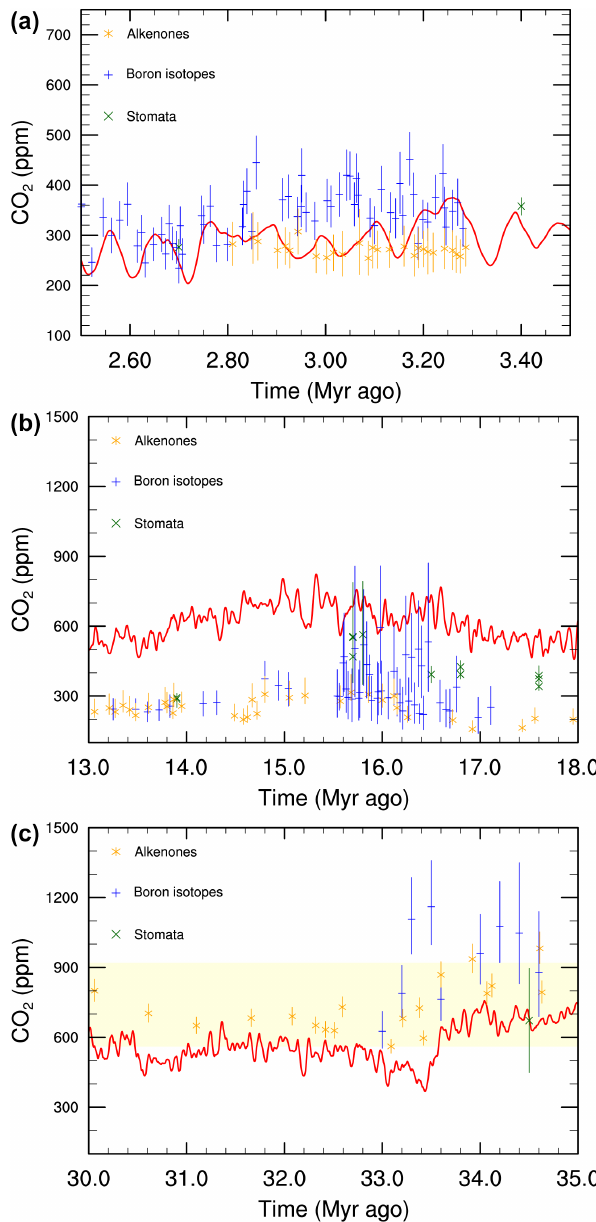
Figure 5. Simulated CO 2 concentrations of the new reference run (red line) for the (a) Late Pliocene (3.5 to 2.5Myr ago), (b) Middle Miocene (18 to 13Myr ago), and (b) Early Oligocene (35 to 30Myr ago); 40kyr running averages are shown. Proxy data reconstructions based on alkenones (Pagani et al., 1999, 2011; Badger et al., 2013) are indicated by orange asterisks. Boron-isotope-based data (Pear- son et al., 2009; Foster et al., 2012; Greenop et al., 2014; Martínez- Botí et al., 2015) are indicated by blue plus symbols. Stomata-based data (Van der Burgh et al., 1993; Kürschner, 1996; Kürschner et al., 2008; Retallack, 2009) are indicated by green crosses. Yellow shad- ing indicates the range of Antarctic glaciation values found by Gas- son et al.